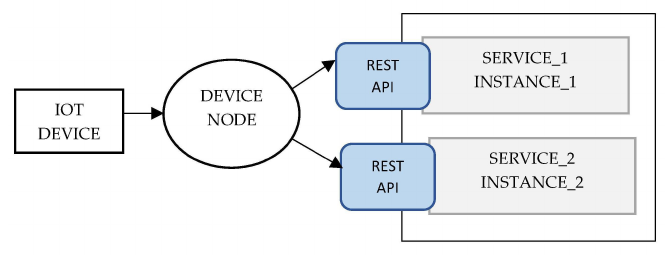
Figure 15. Placement of microservice IoT